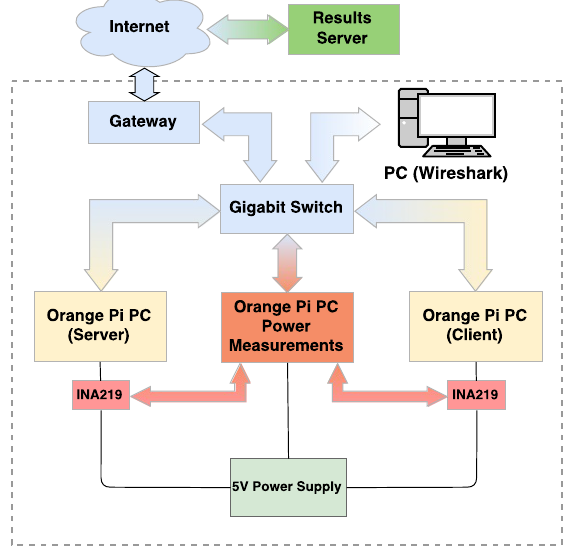
Figure 6. Detailed testbed